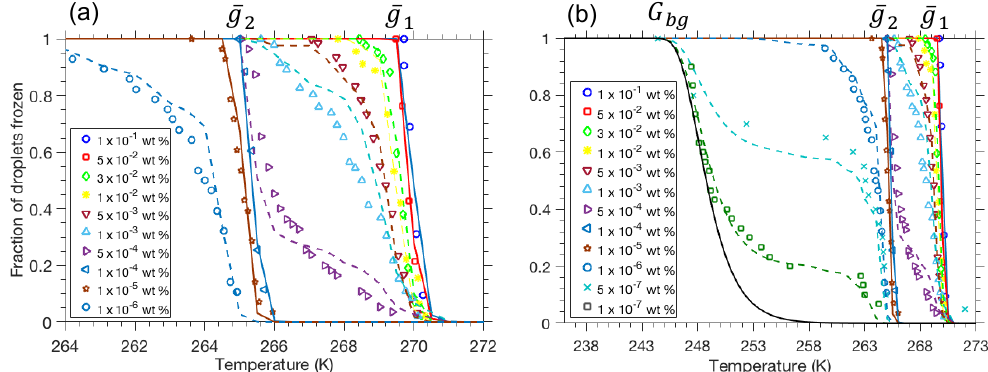
Figure 2. (a) Frozen fraction temperature spectra for Snomax mass concentrations of 1 1 10 − 3 , 5 10 − 4 , 1 10 − 4 , 1 10 − 5 , and 1 10 − 6 wt% (symbols). Critical area fits using two distinct Snomax distributions of HIN × × × × × activity (solid lines) are shown for some droplet freezing curves, while the rest of the freezing curves are modeled with the mixing model (dashed lines). (b) All frozen fraction curves shown in (a) in addition to the lowest Snomax concentration frozen fraction curves of 5 and 1 10 − 7 wt%. The lowest concentration freezing curves are modeled using random sampling by n draws of the g 2 distribution of HIN × activity. The solid black line is the assumed frozen fraction curve induced by the background impurities in the